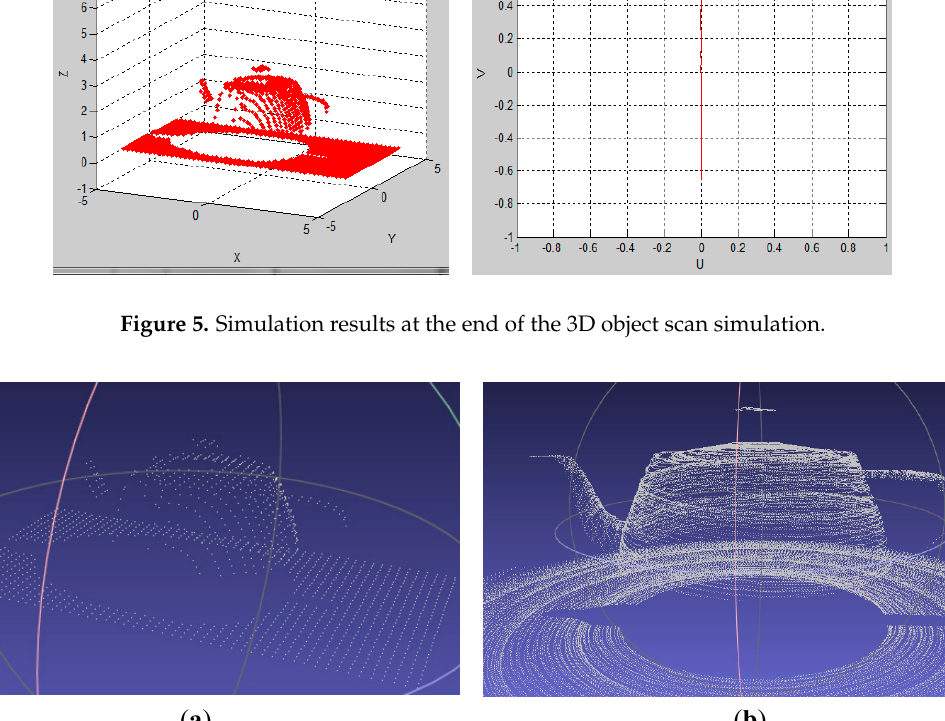
Figure 6. ( a ) Scanned teapot (3D point mesh) viewed in MESHLAB; ( b ) Best 3D scanning result (3D point mesh) viewed in MESHLAB, obtained with a 32 PSD sensor array.